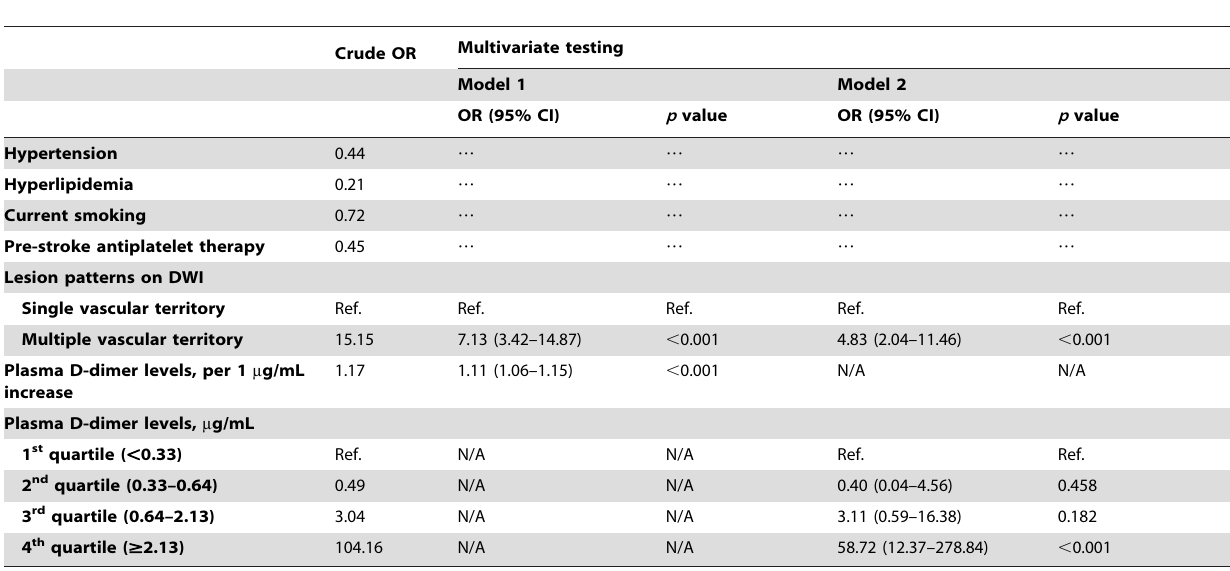
Table 2. Multiple logistic regression analysis: Independent predictors for cancer-related stroke vs. cryptogenic stroke without active cancer.